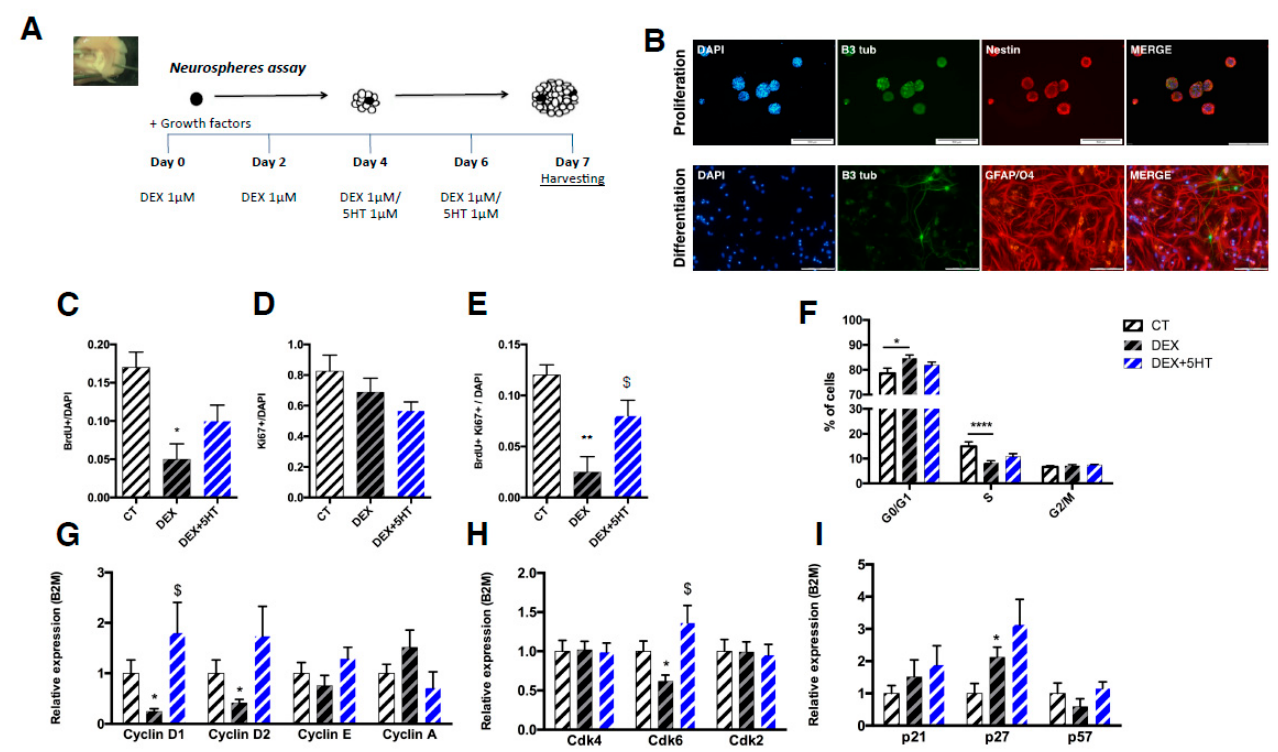
Figure 2. Neurosphere culture as a model to study the hippocampal progenitor cells proliferation and cell cycle. ( A ). Schematic representation of the neurosphere assay. ( B ). Representative pictures of immunofluorescence of neurosphere expansion and differentiation into neural phenotypes (scale bar = 100 µ m). ( C – E ). Proliferation assessed by BrdU (24 h, C ), Ki67 ( D ) and BrdU/Ki67 ( E ) immunostaining in split neurospheres. ( F ). Cell cycle distribution analysis with PI staining. ( G – I ). Gene expression analysis of G1 cyclins ( G ), Cdks ( H ), and CdK inhibitors ( H ). Error bars denote SEM. * Denotes the effect of DEX-stimulation; $ denotes the effect of 5-HT compared DEX-treated cells. * /$ p < 0.05; ** p < 0.01; **** p < 0.0001. Abbreviations: CT: control; DEX – dexamethasone;